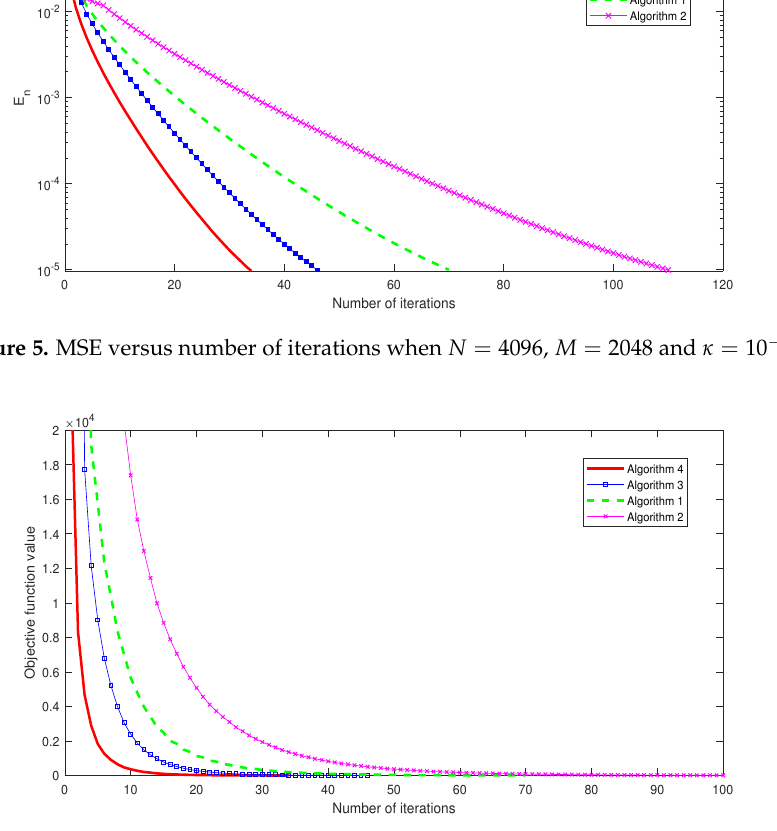
Figure 6. The objective function value versus number of iterations when N = 4096, M = 2048 and κ = 10 − 5 .